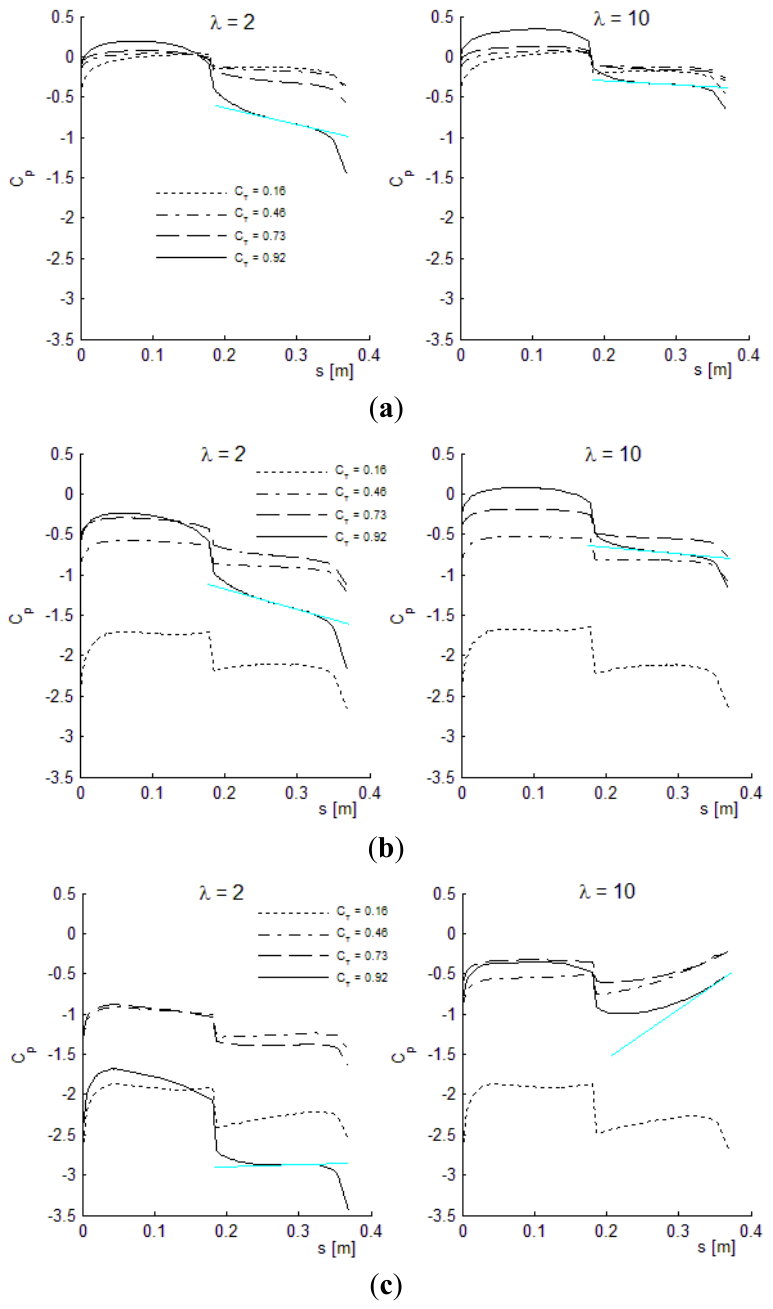
Figure 21. Pressure coefficient distributions along axial part of centerbody for different TSR and C T . Nacelle/rotor: Centerbody with cylindrical root section. Left: λ (cid:3404) 2 . Right: λ (cid:3404) 10 . ( a ) HAWT; ( b ) Hansen DAWT; ( c ) Multi-element